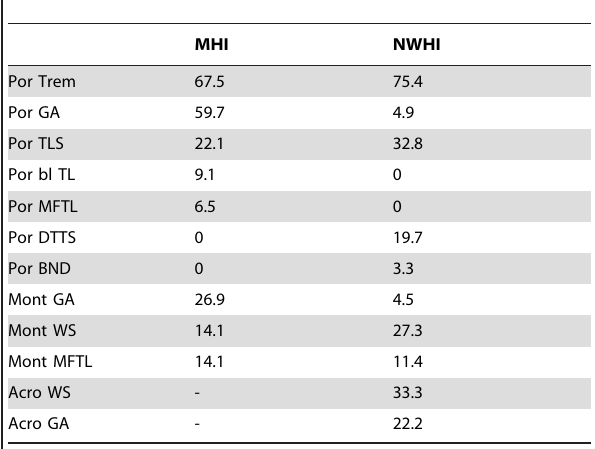
Table 3. Frequency of occurrence (FOC) of different coral diseases within the main and northwestern Hawaiian Islands. Table 4. Average prevalence of diseases found on the reefs within the main and northwestern Hawaiian